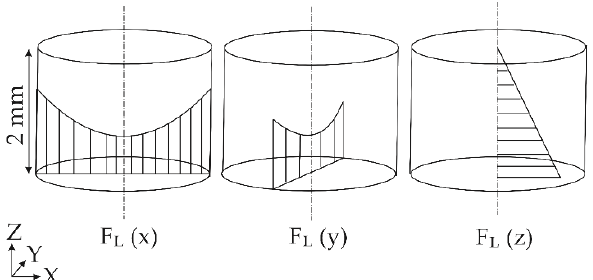
Figure 4. Qualitative three-dimensional distribution of the Lorentz forces in x-, y-, and z-directions of a 2 mm aluminium alloy sheet.